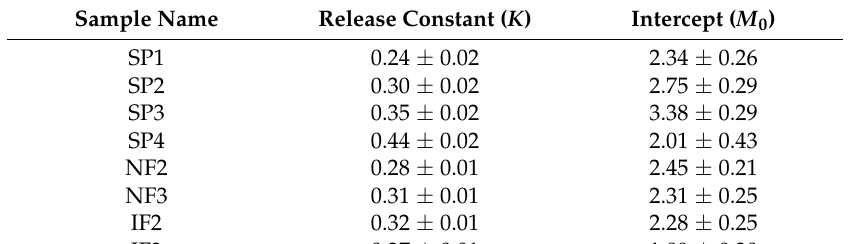
Figure 8. Short-term release data (symbols) and fitting (lines) using the Higuchi equation. Table 1. Higuchi equation fitting parameters.